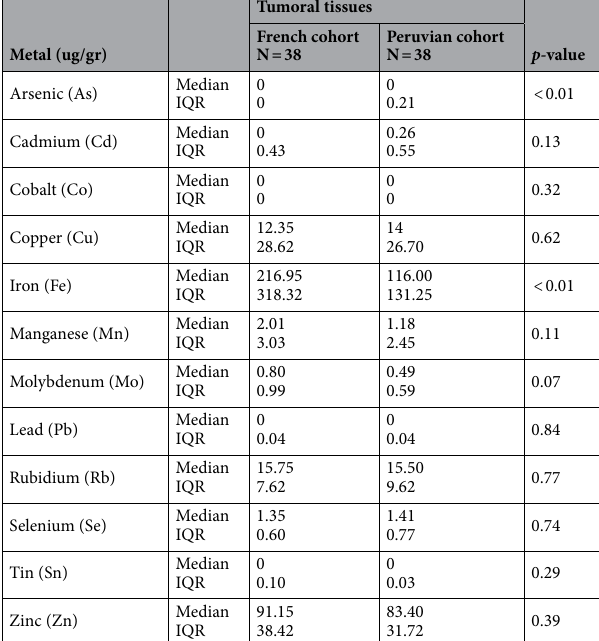
Table 3. Metal quantification in tumoral tissues between both cohorts. Data are presented median and interquartile range (IQR). Levels of significance ( p < 0.05) were calculated with Mann Whitney